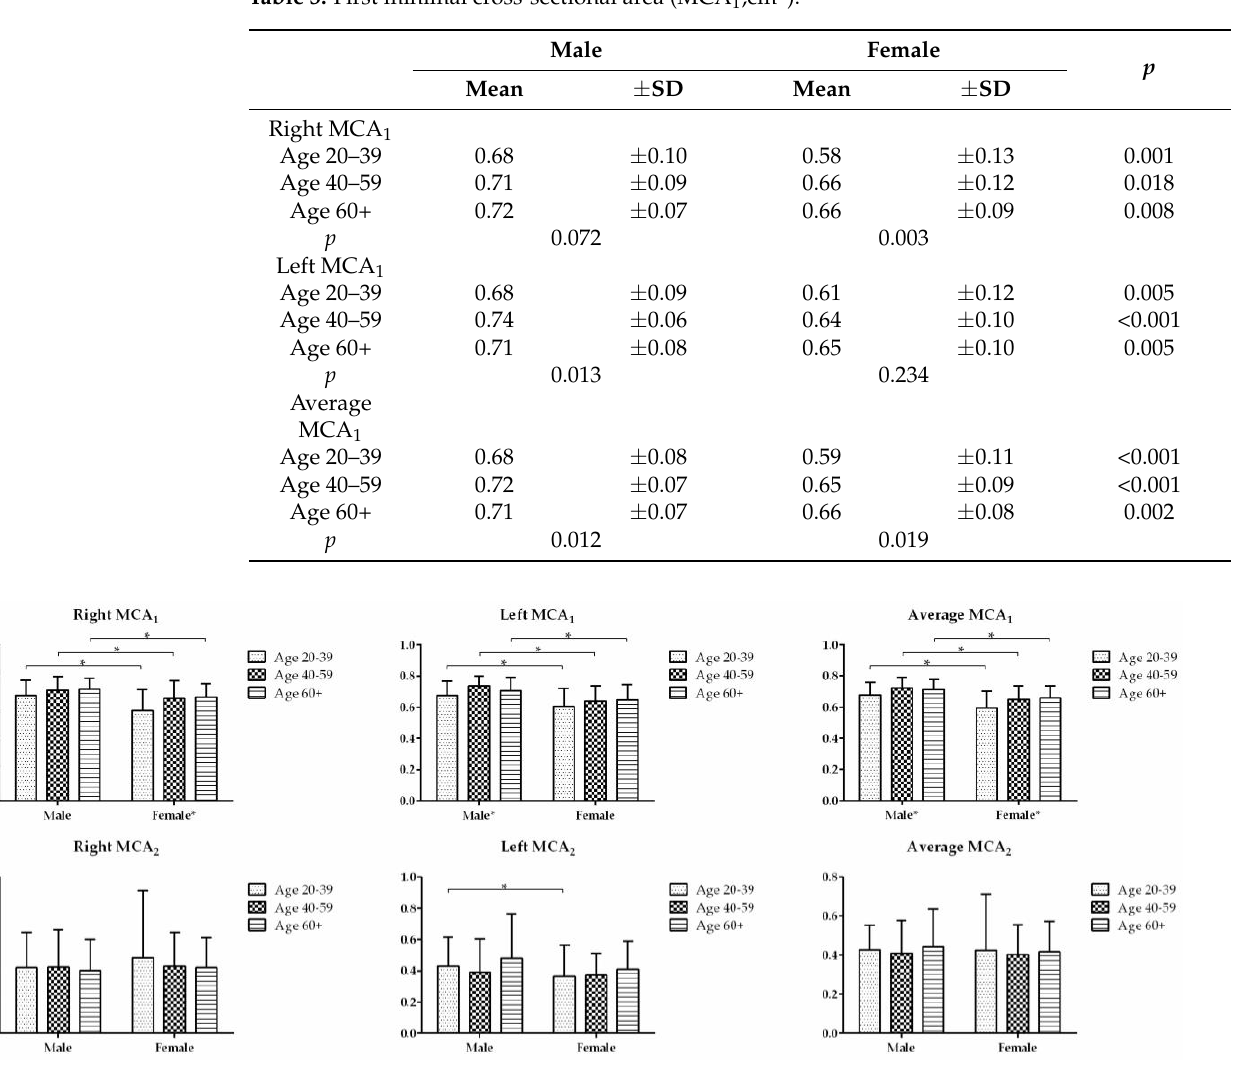
Figure 3. The first minimal cross-sectional area (MCA 1 ) and second minimal cross-sectional area (MCA 2 ) in three age groups were compared between the males and females. * indicates the difference is statistically significant ( p < 0.05).